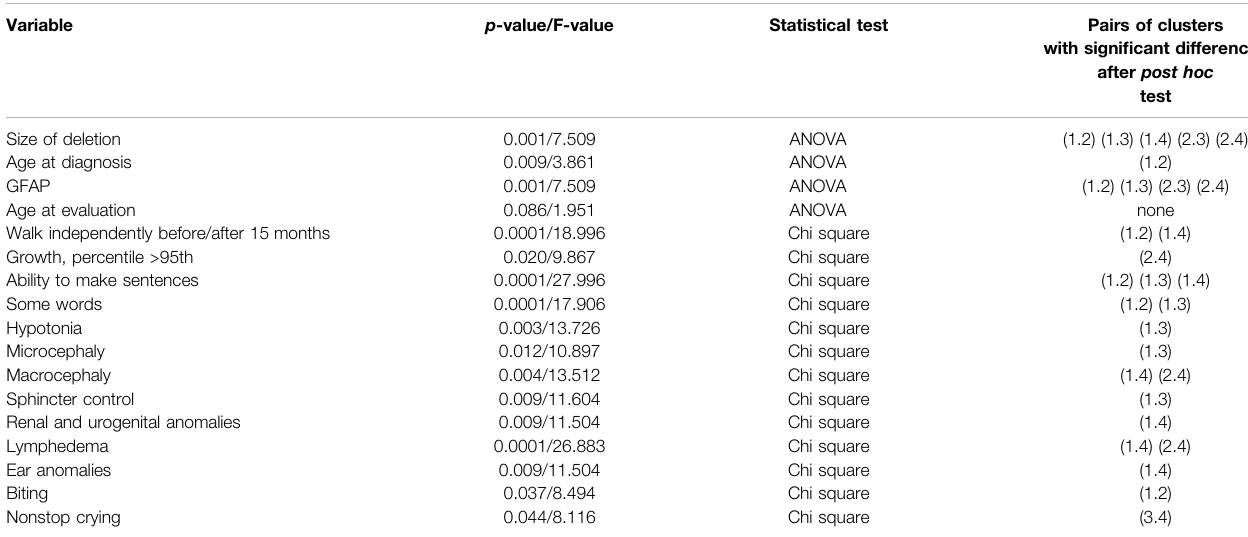
TABLE 6 | Comparison between Ward ’ s clusters obtained using deletion size.